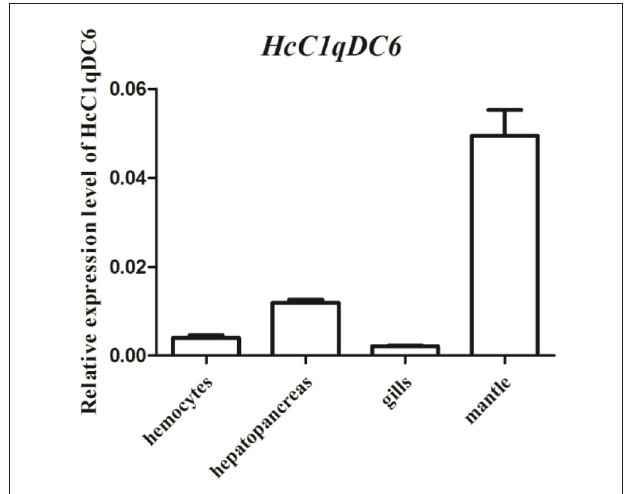
FIGURE 4 | qRT-PCR analysis of HcC1qDC6 in the hemocytes, hepatopancreas, gills, and mantles of H. cumingii .